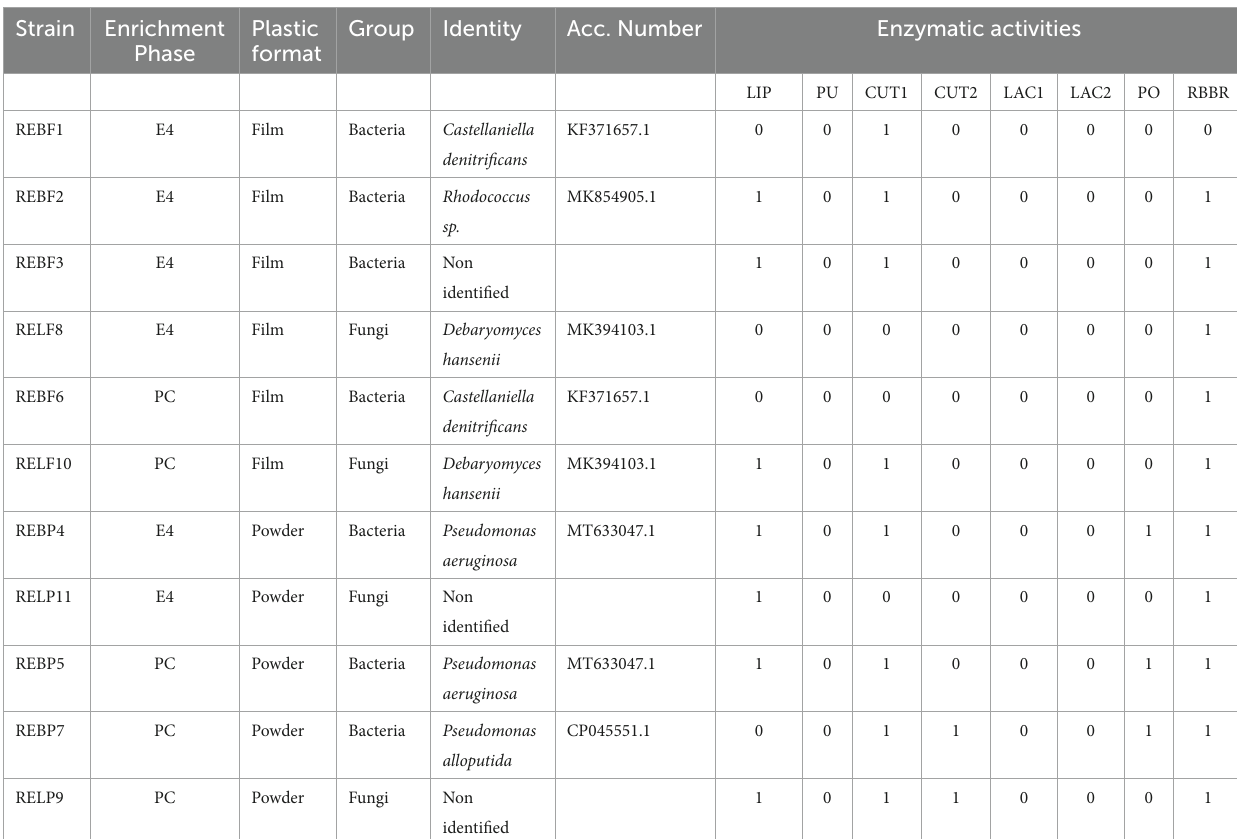
TABLE 1 Enzymatic